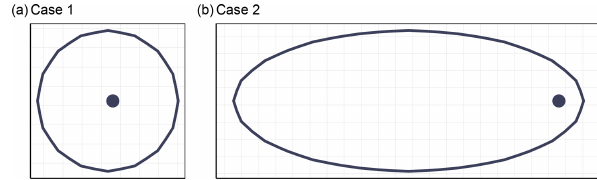
Table 1. Scenarios used for model calibration and